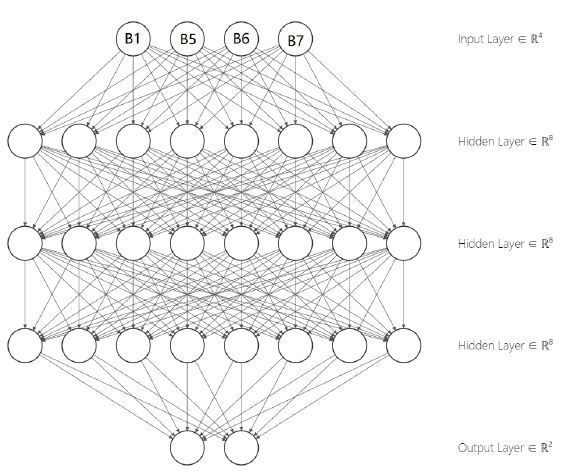
Figure 4. The structure of our ANN model.